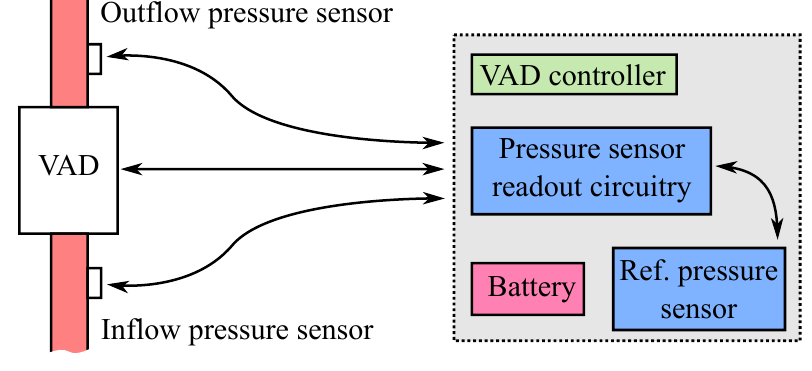
Figure 5. VAD architecture with integrated inflow and outflow pressure sensors and